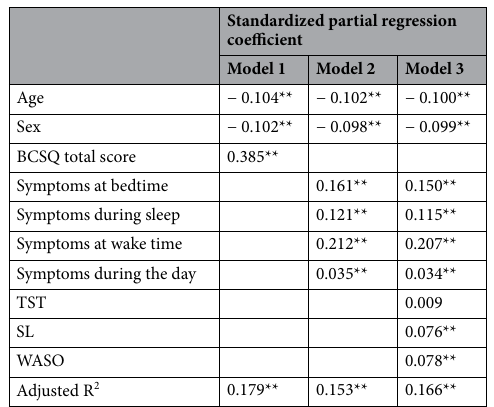
Table 4. Multiple regression analysis of sleep problems (sleep disorders and sleep habits) on TDS (emotional and behavioral problems). BCSQ total score consists of the four subcategories of symptoms at bedtime, during sleep, at wake time, and during the day. **P < 0.01, *P < 0.05. SL sleep latency, TST total sleep time, WASO wake after sleep